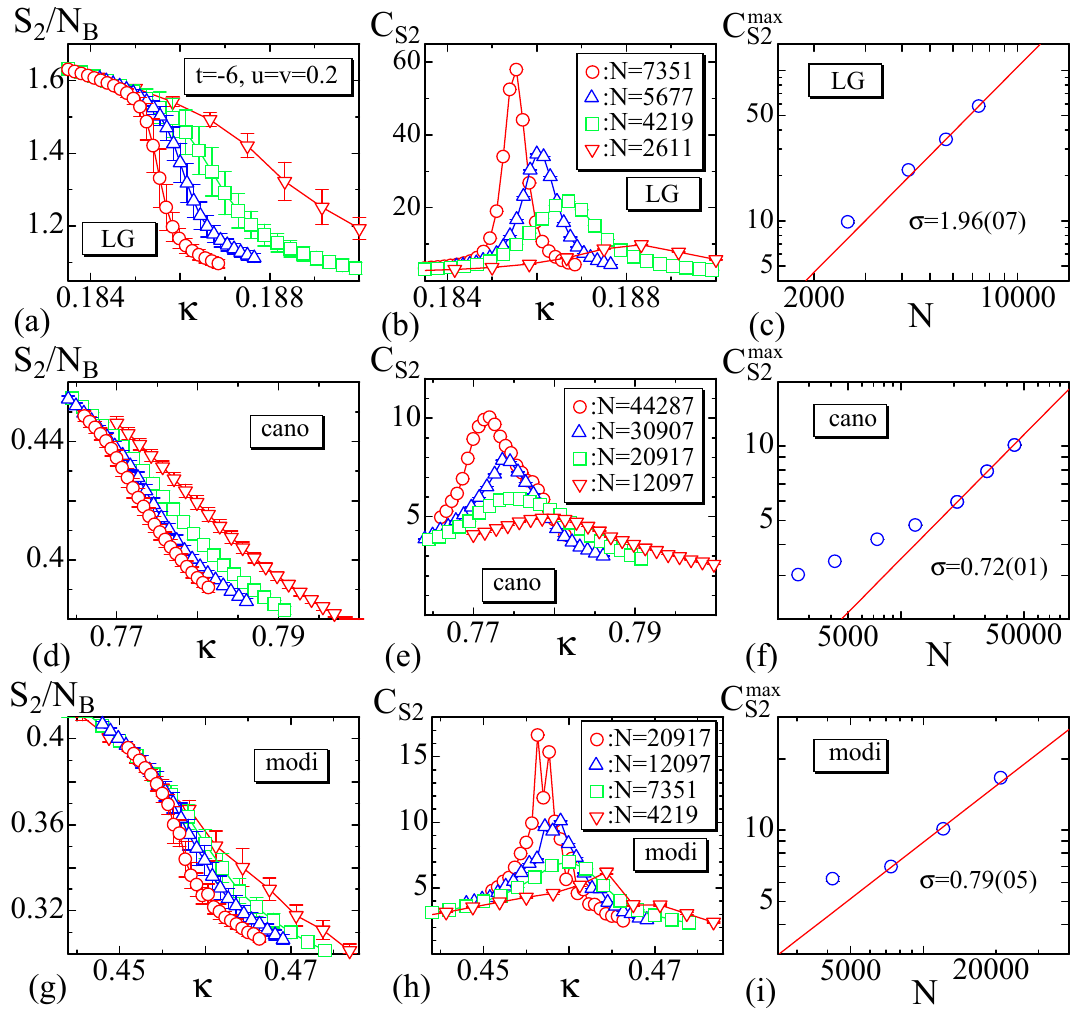
Figure 7. The bending energy per bond S 1 / N B , the specific heat C S peak value C max S